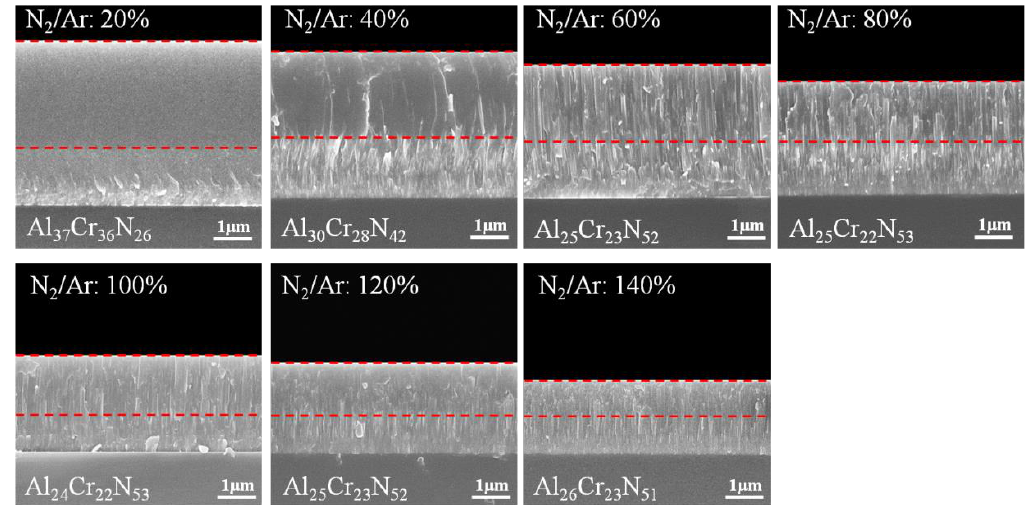
Figure 3. Cross-sectional scanning electron microscope (SEM) images of coatings deposited under various N 2 /Ar flow ratios.